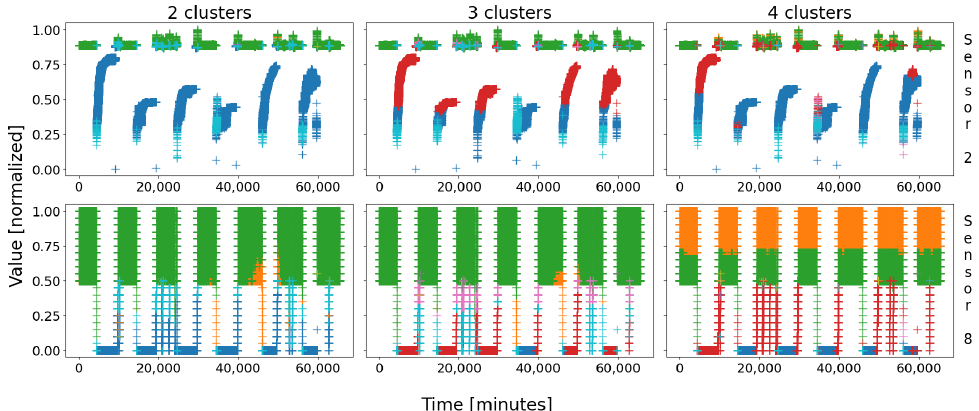
Figure 3. Battery 1 ( D 1 ) clustering comparison (3 × 3 SOM). When using a SOM with D 1 , one among three sets of clusters appears; each column is one of these configurations, and the rows are two sensors of the database given as examples, sensor 2 ( top ) and sensor 8 ( bottom